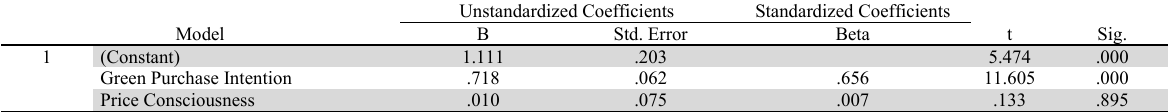
Multiple regression with Price as Independent Model